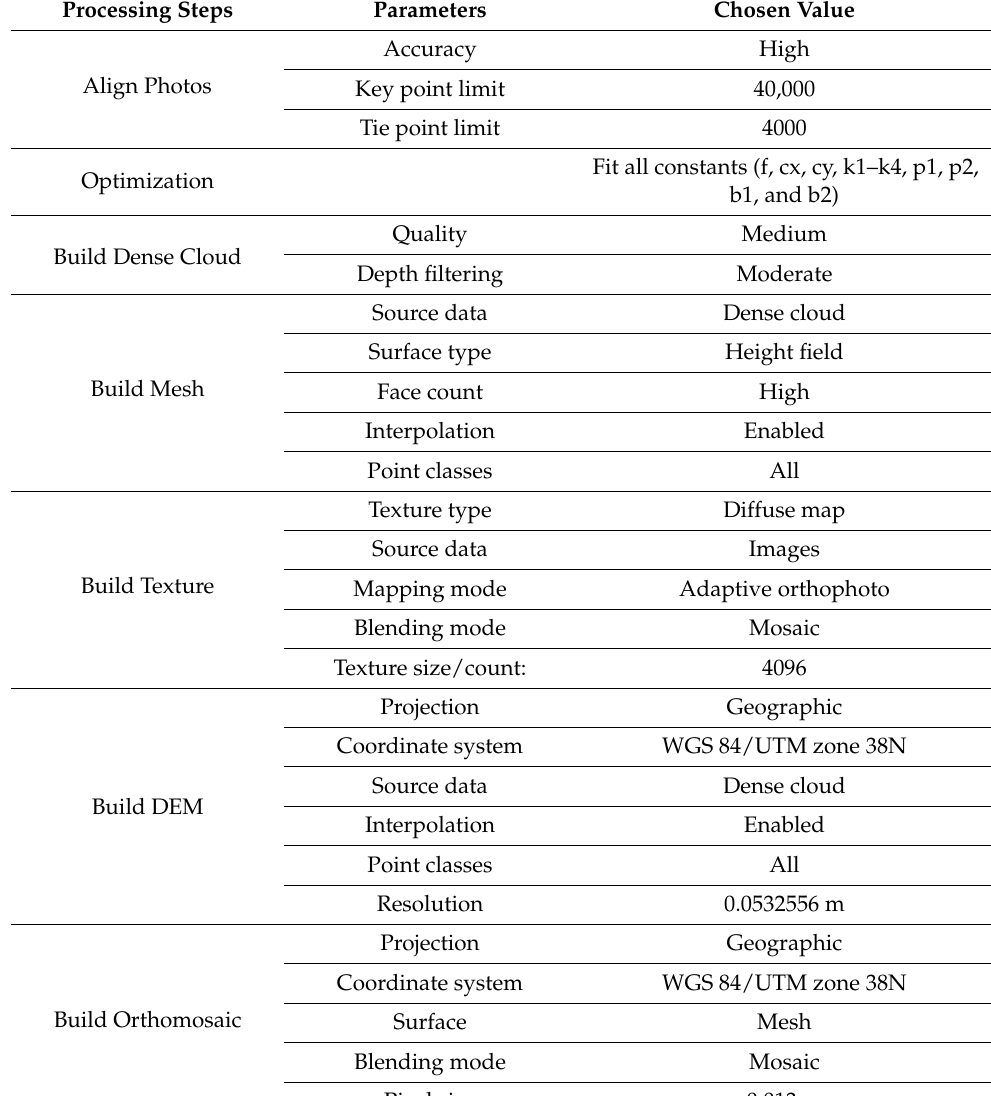
Table 2. Setting parameters of Agisoft Metashape used in this